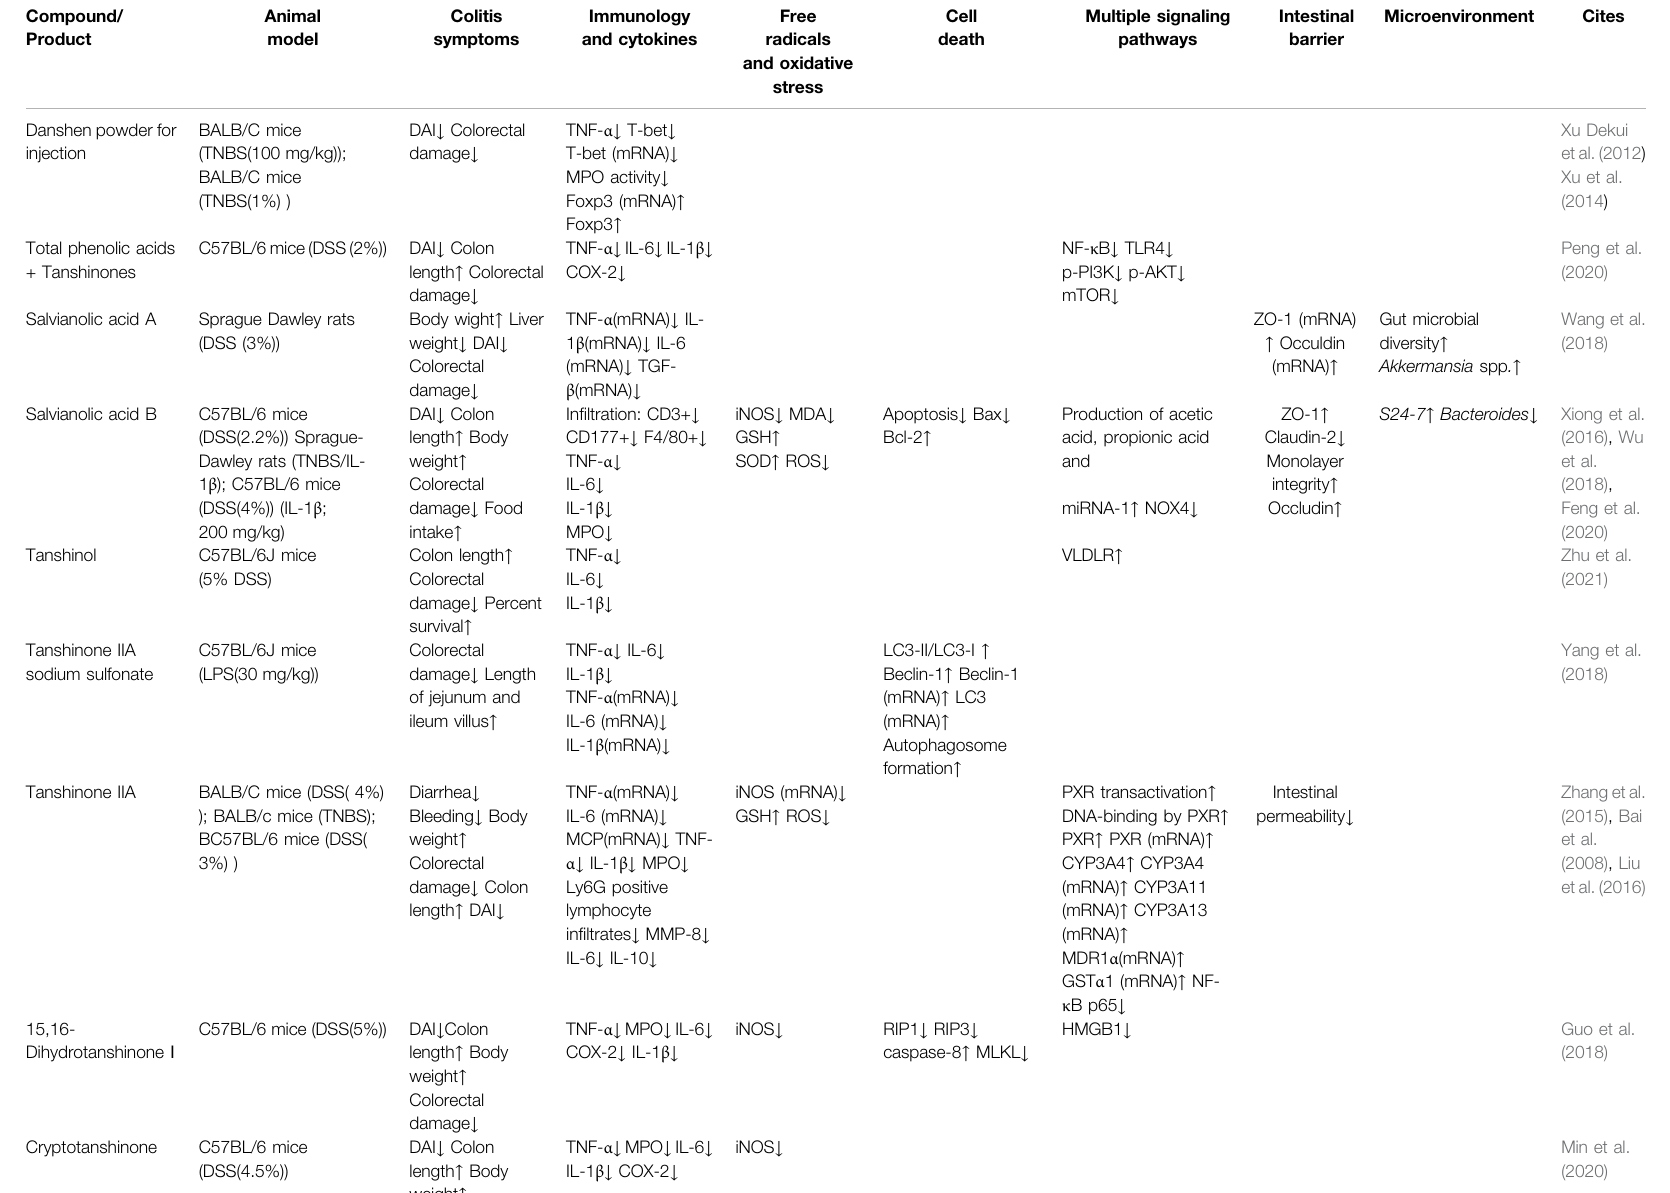
TABLE 1 | Pharmacological details of action of Danshen compounds in experimental